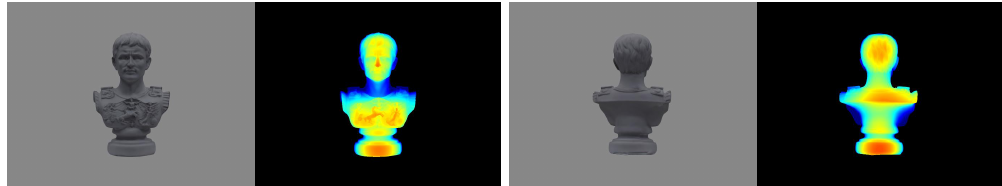
Figure 13. Sample synthetic color and (colorized) depth images of Caesar sculpture. We set in total 24 cameras poses along a circular trajectory and for each pose one aligned RGB-D images pair was rendered.